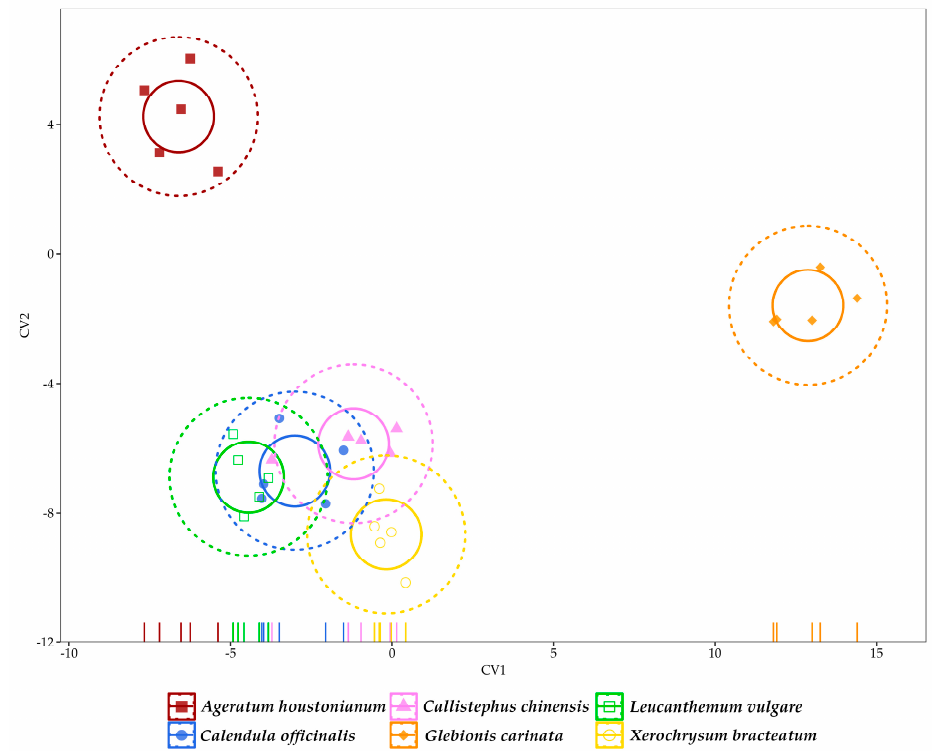
Figure 11. CVAsws biplot. Different colours and shapes distinguish individuals from different group species. The solid inner circles represent the 95% tolerance region for the population mean; the outer dotted circles represent the 95% confidence region of the group means. The coloured rugs above the x -axis represent the projection of the individuals belonging to each group.